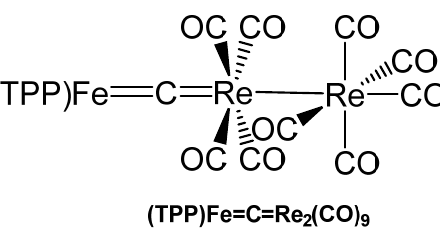
Figure 39. Structural representation of the Fe = C = Re carbido complex (TPP)Fe = C = Re 2 (CO) 9 .